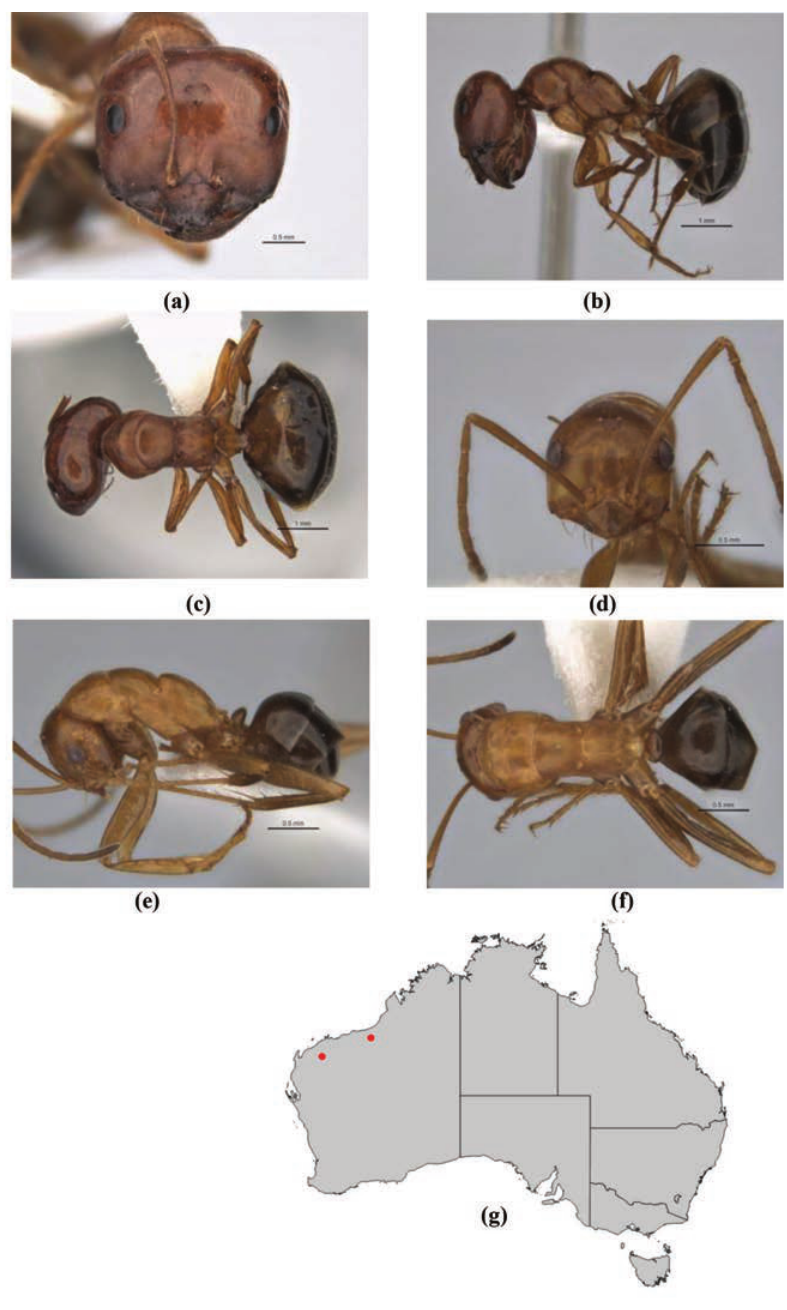
Figure 10. Melophorus clypeatus sp. n.: major worker paratype (JDM-001497–top ant) frons ( a ), pro- file ( b ) and dorsum ( c ); minor worker holotype (JDM32-001497–bottom ant on separate pin) frons ( d ), profile ( e ) and dorsum ( f ); distribution map for the species ( g ). Low resolution scale bars: 1 mm ( b, c ); 0.5 mm ( a, d–f